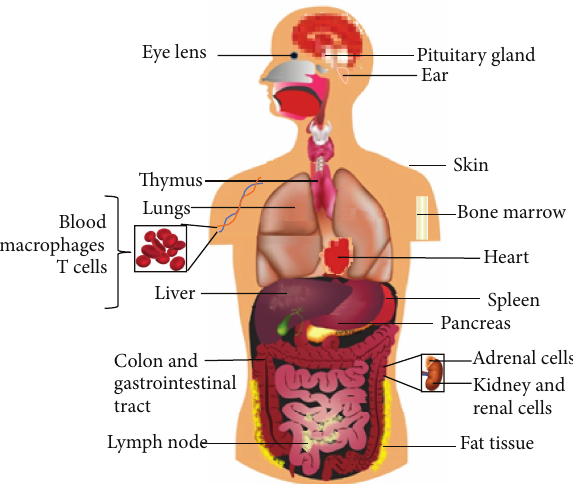
Figure 1: MIF expression pattern. MIF, a cytokine, is distributed throughout almost the entire body. This is because MIF is part of the innate immune system or first line of immune